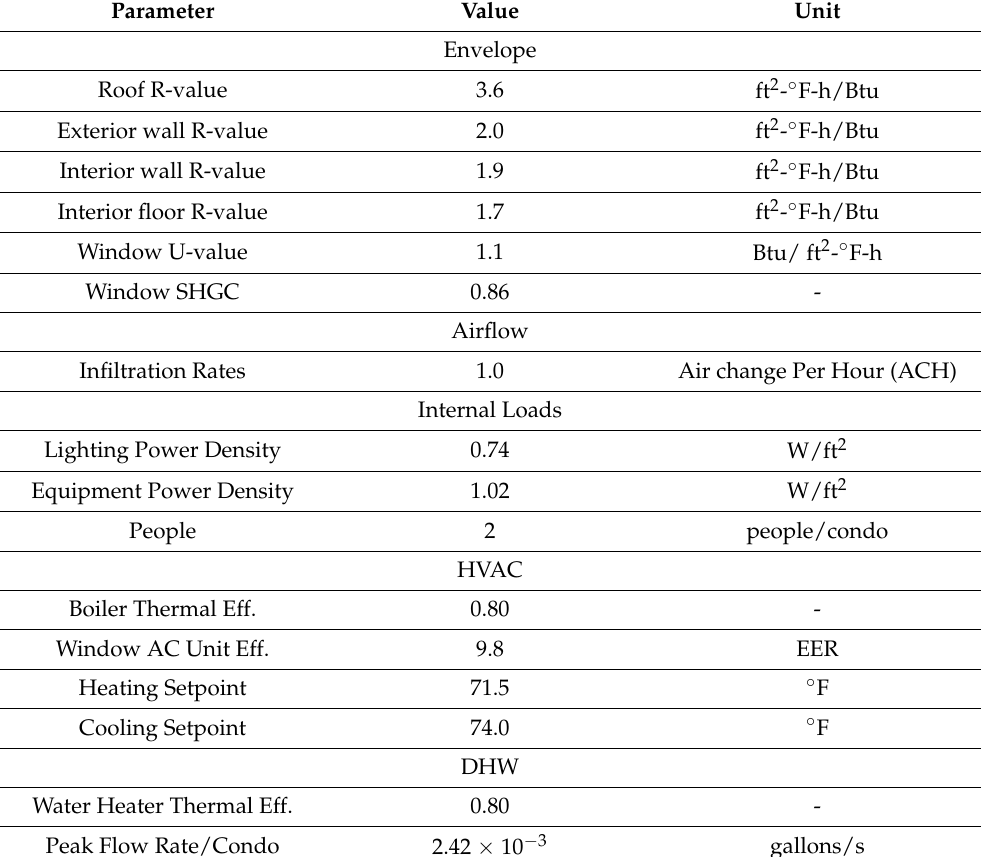
Table 1. Base Case Energy Modeling Assumptions (1 Btu/ft 2 -oF h = 5.68 W/m²·K), (1 W/ft 2 = 10.76